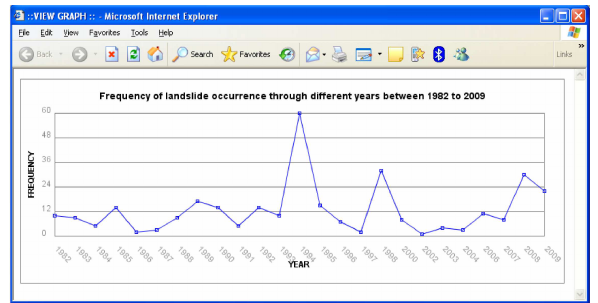
Figure 7. Frequency of occurrence of landslide in the national highway road corridor generated using open source spice chart